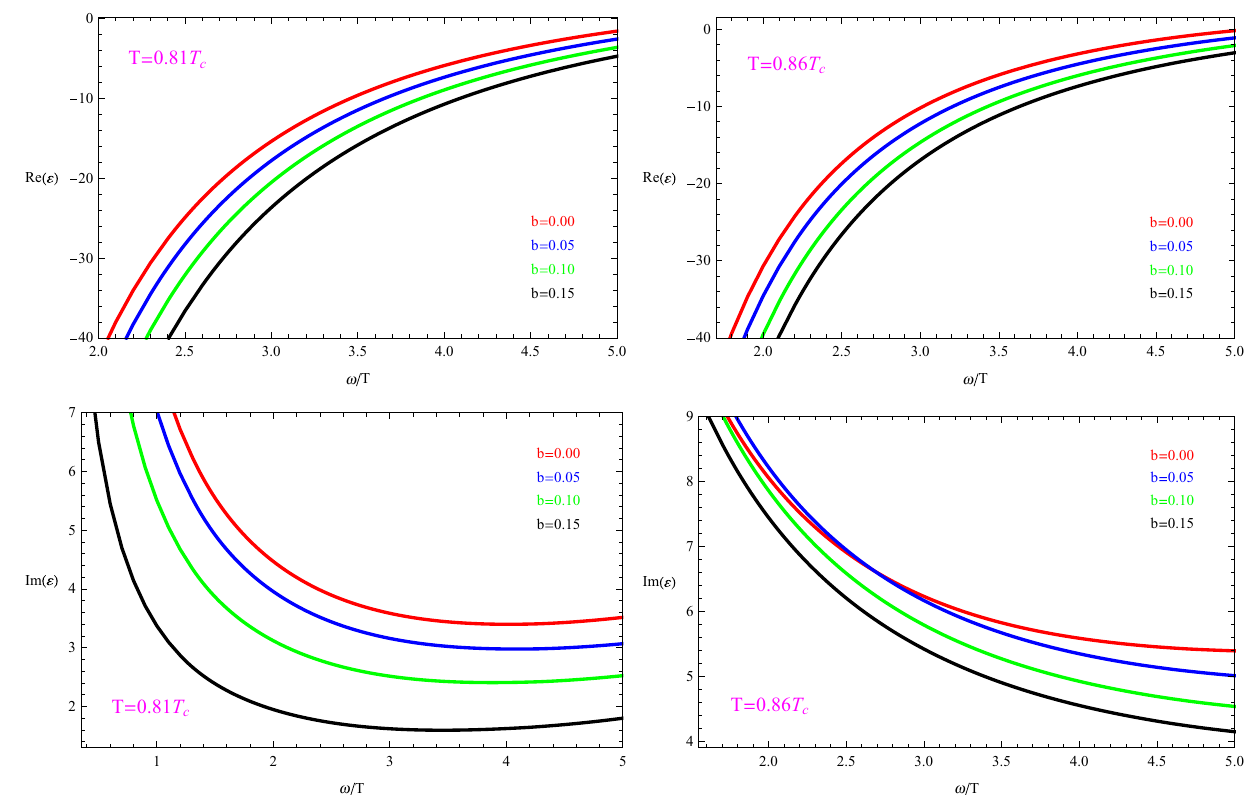
Fig. 2 The permittivity (cid:11) as a function of ω/ T with the fixed temper- atures T = 0 . 81 T c (left) and T = 0 . 86 T c (right) for different values of the Born–Infeld parameter b . The four lines in each panel from top to